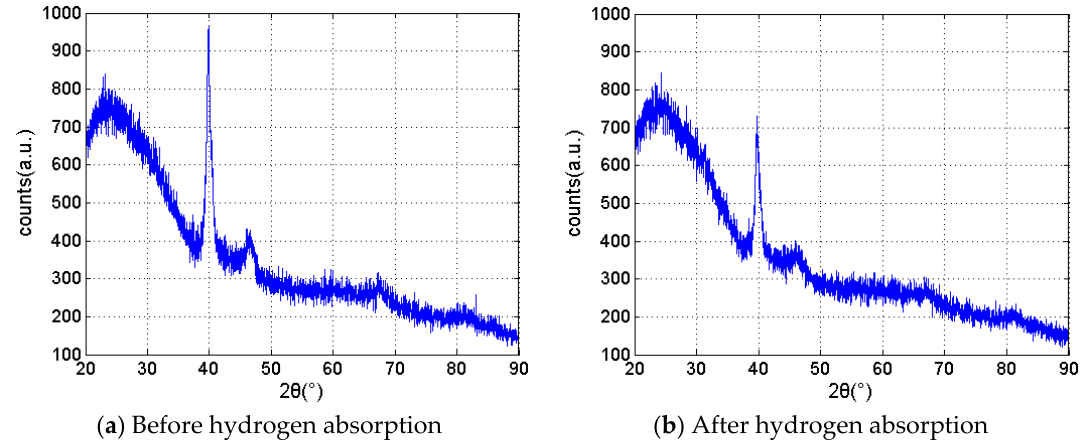
Figure 9. XRD spectrum of hydrogen-sensitive film before and after hydrogen absorption. ( a ) Before hydrogen absorption; ( b ) After hydrogen absorption.